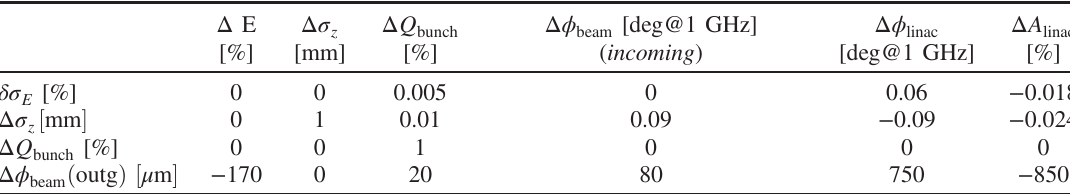
TABLE II. Matrix of CLIC drive beam parameter interdependences in linear approximation [4,11]. The errors in the parameters of incoming bunches (columns) contribute in the compressor chicane to the errors in the parameters of the outgoing bunches (rows). The linac tolerances are stated for the linac section before the bunch